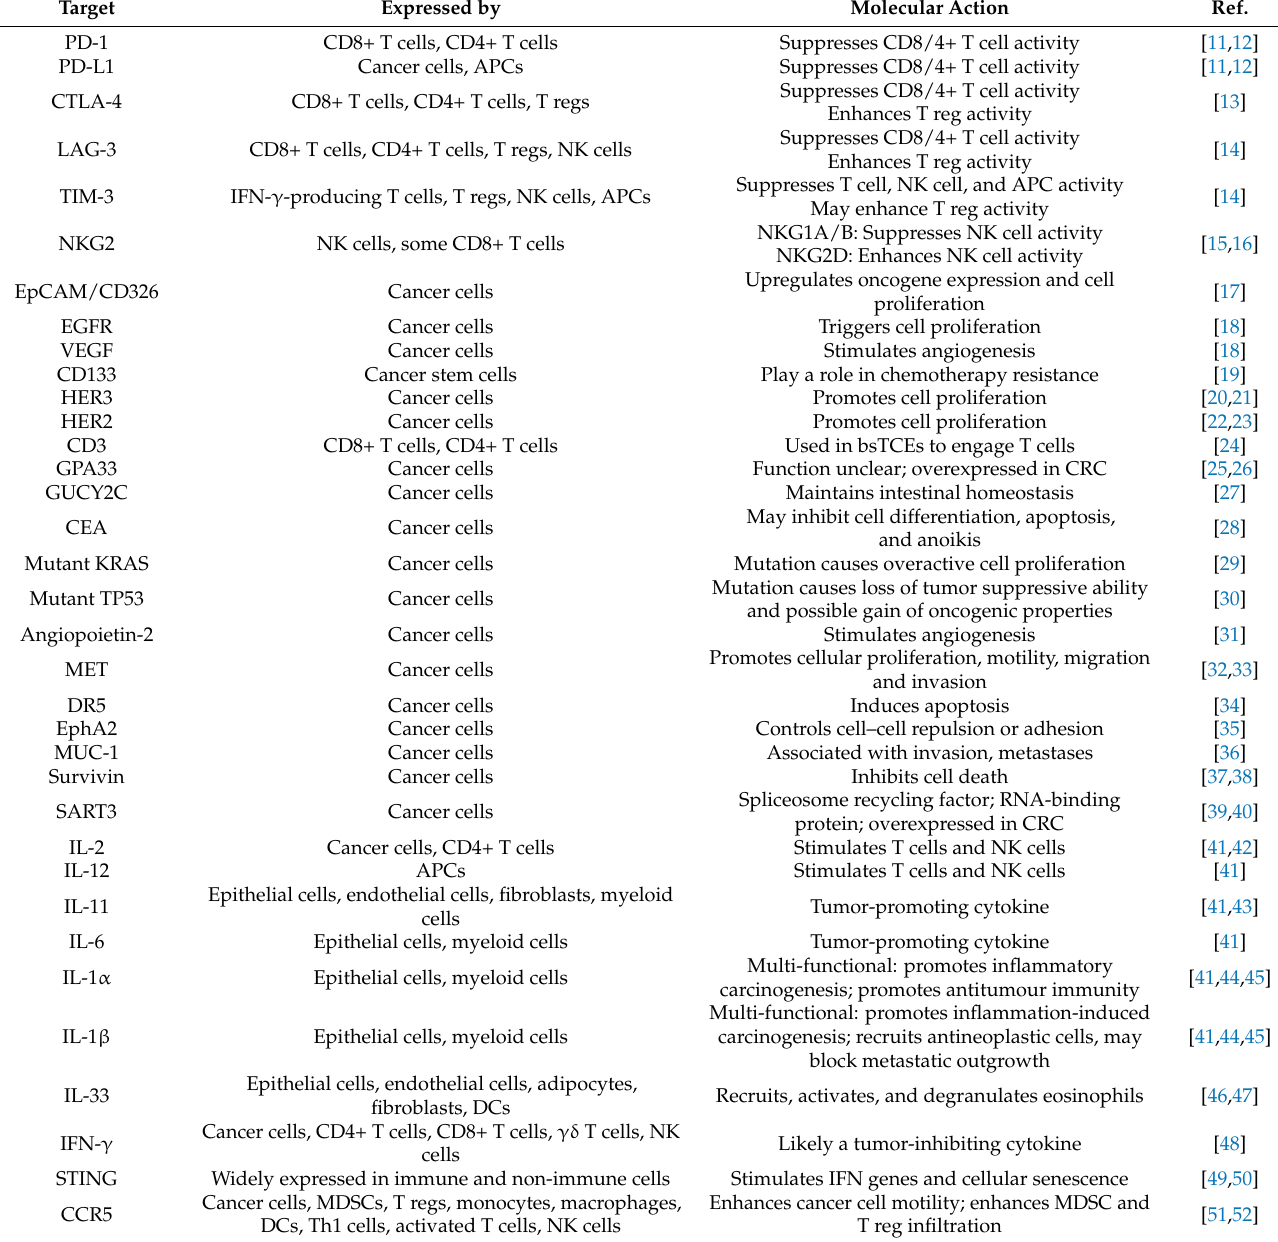
Table 1. The molecular action and cellular expression of targets relevant to IT in